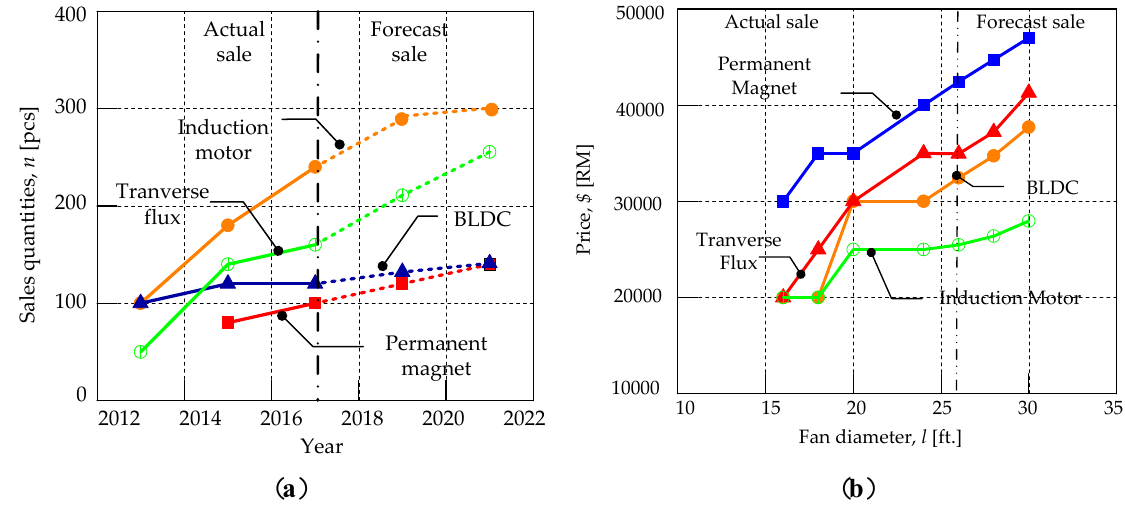
Figure 14. Product technology forecasting ( a ) Motor types sales ( b ) Motor price forecasting . Table 5. Increment percentage of monstrous fan forecasting according to motor types.